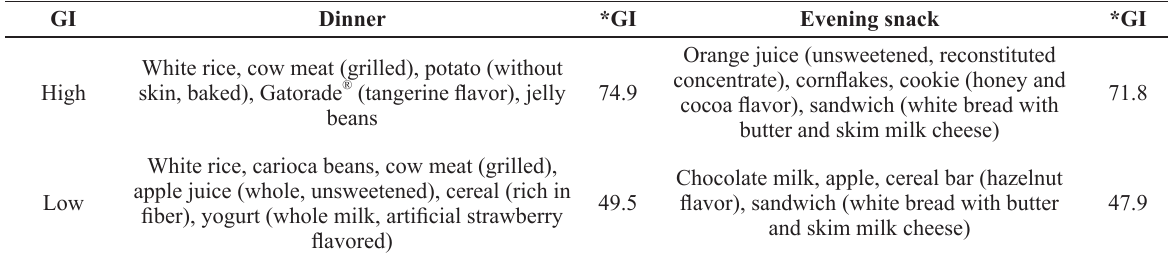
Meals food composition (dinner and evening snack) with high and low GI.